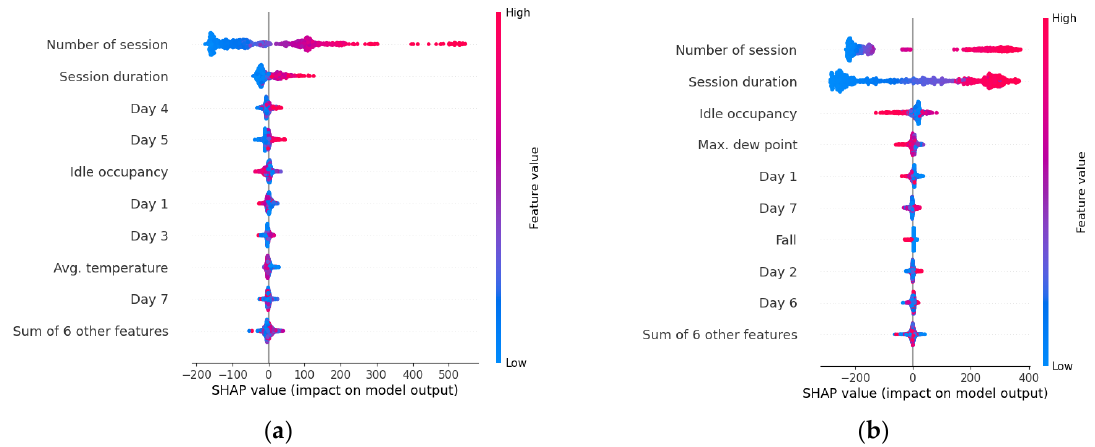
Figure 10. Feature density and its impact on model output. ( a ) Caltech. ( b ) JPL.